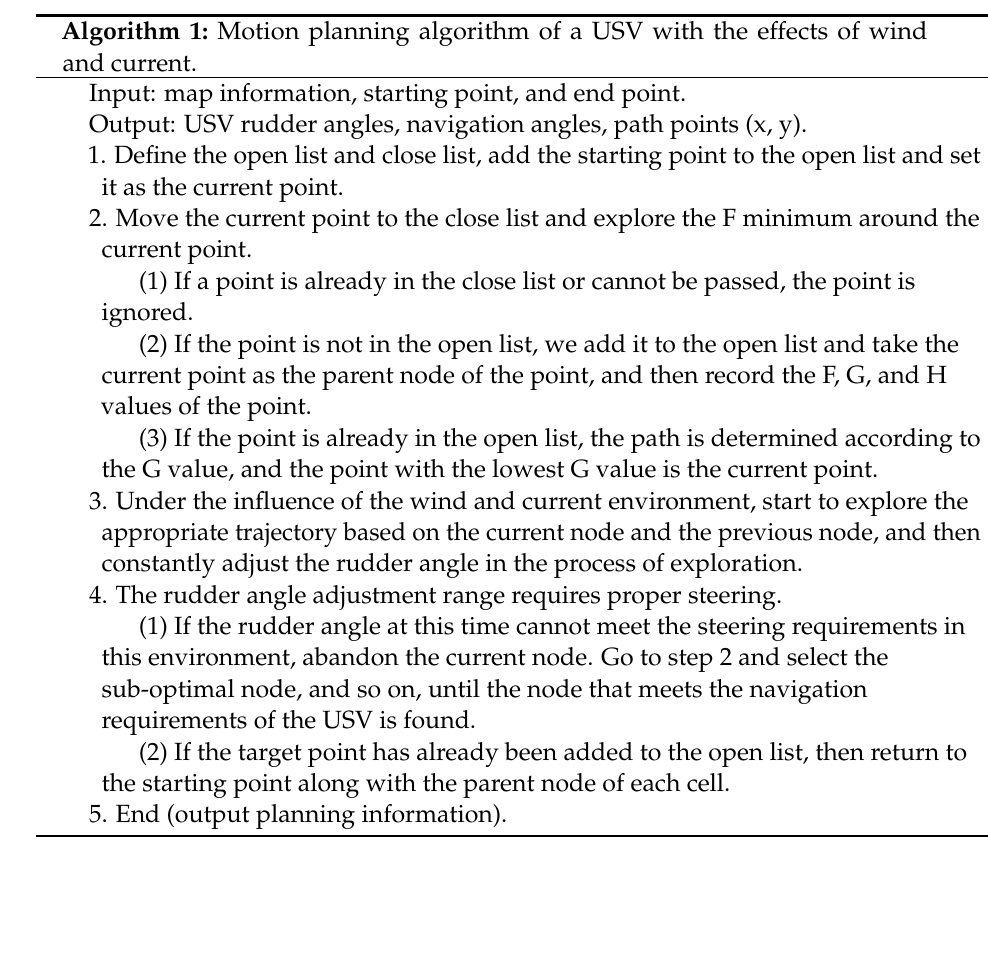
Algorithm 1: Motion planning algorithm of a USV with the effects of wind and